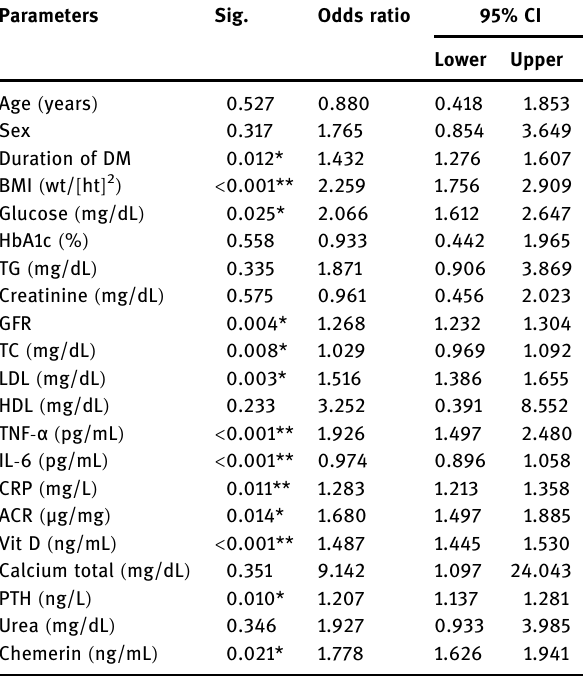
Table 2: Regression analysis of albuminuria risk factors in T2DM Parameters